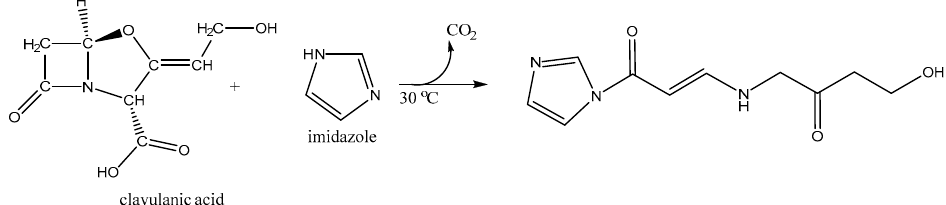
Figure 7. Derivatization of CA with imidazole: Alkylation of secondary nitrogen in the imidazole.